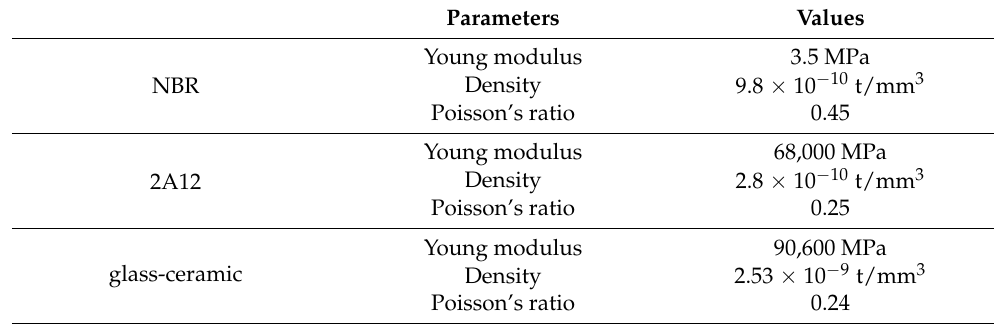
Table 1. Simulation conditions set in